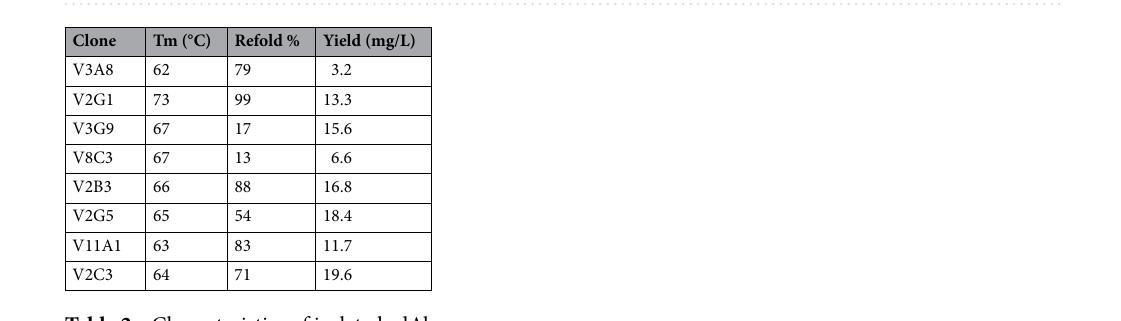
Figure 1. Amino acid sequences of representative sdAb selected for ability to bind irradiated VEEV-TC-83. Sequences are given in 1-letter amino acid code. Alignment was performed using Multalin 25 . Red indicates high homology, while lower homology is in blue. CDR regions are defined using the IMGT definitions 27 .